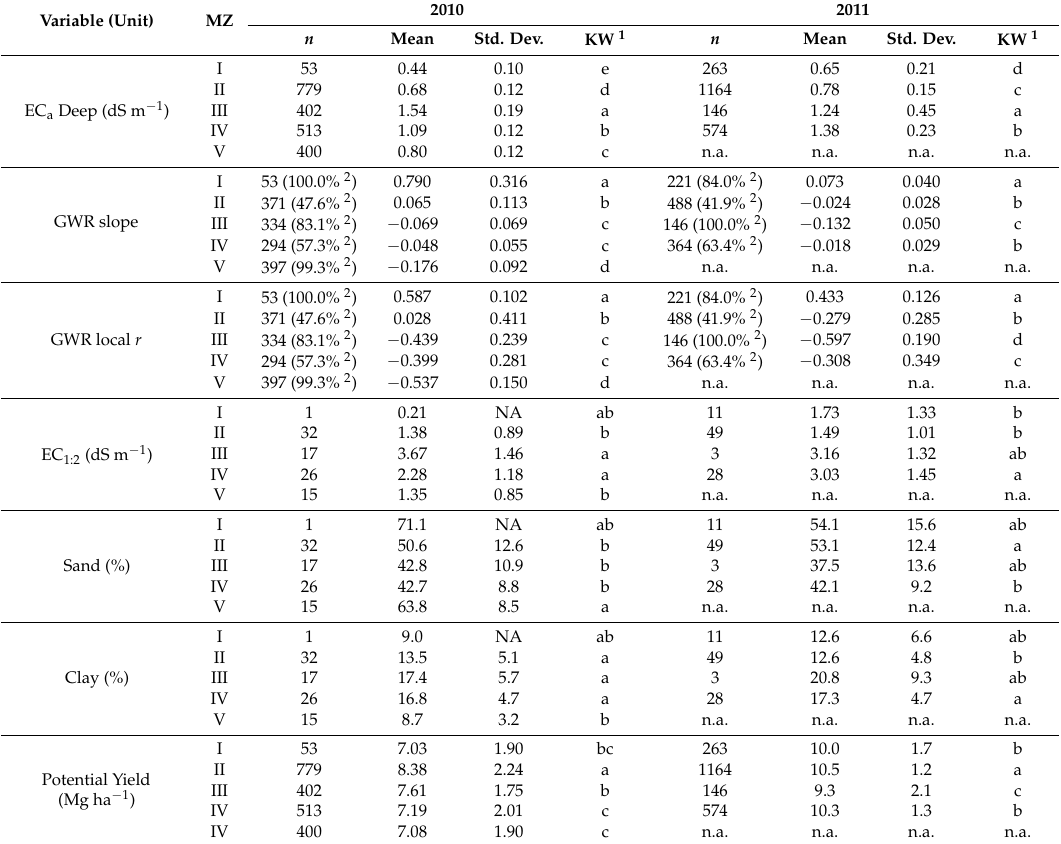
Table 2. Count ( n ), mean, and standard deviation (Std. Dev.) of apparent electrical conductivity for the 0–1.5-m soil profile (EC a Deep), local regression slope and Pearson correlation coefficient ( r ) obtained from significant geographically weighted regressions (GWR), soil salinity (EC 1:2 ), sand and clay contents, and potential yield estimations at each time-specific management zone (MZ) for 2010 and 2011 (n.a. = not available; NA = not